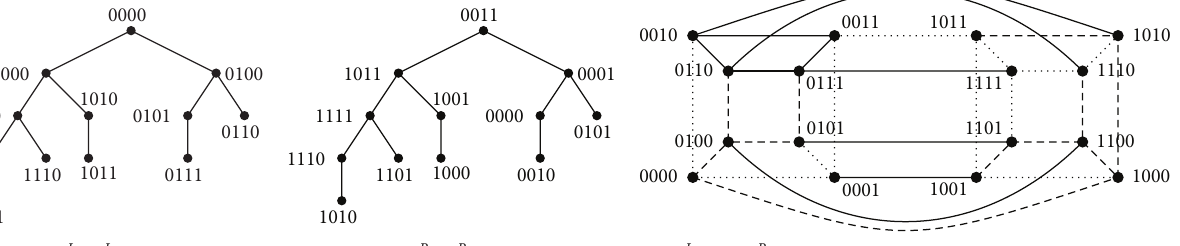
Figure 3: Embedding F 𝐿 3 and F 𝑅 3 in 𝑄 3 .